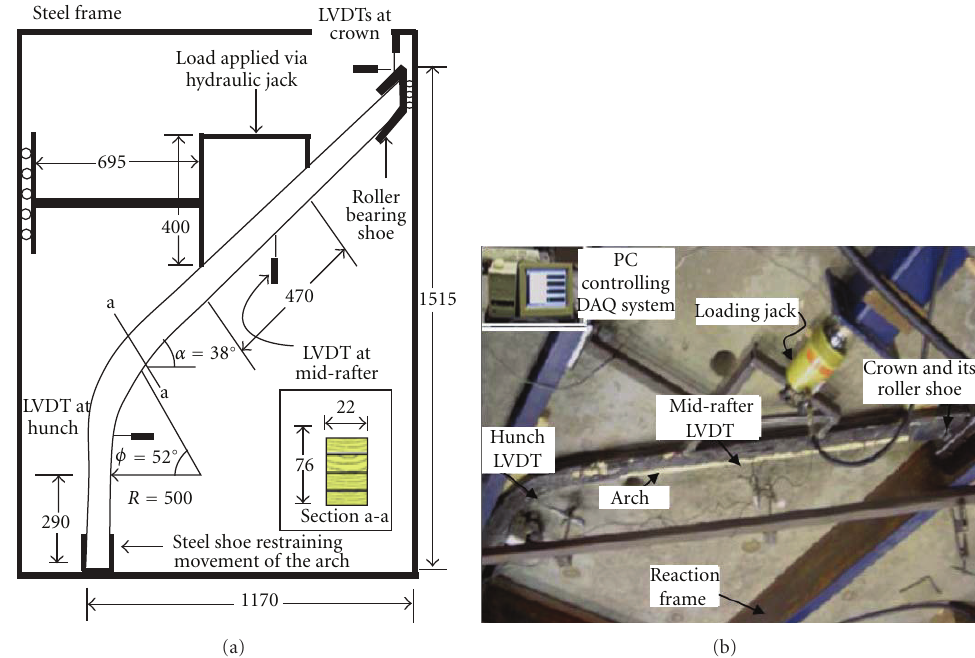
Figure 1: (a) Schematics and dimensions of the test arch specimen and the experimental setup. (b) photo of the actual test setup (drawing not to scale; all dimensions in